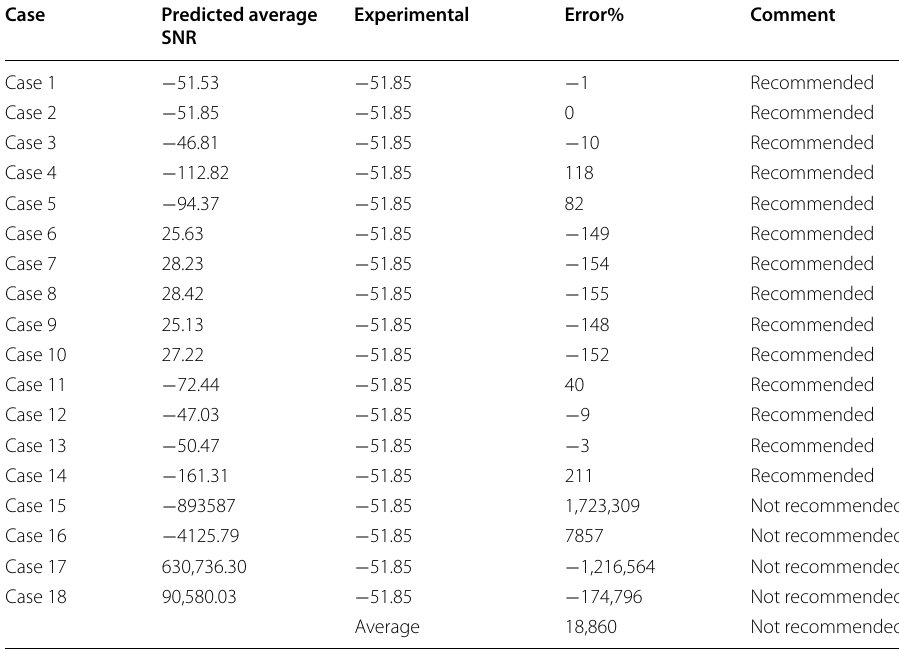
Table 16 Confirmation test results on the predictive